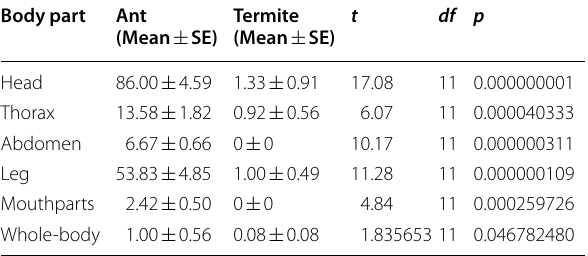
Table 1 Frequency of different body parts of ants and termites in the faecal matter of Indian pangolin in Gir National Park Body